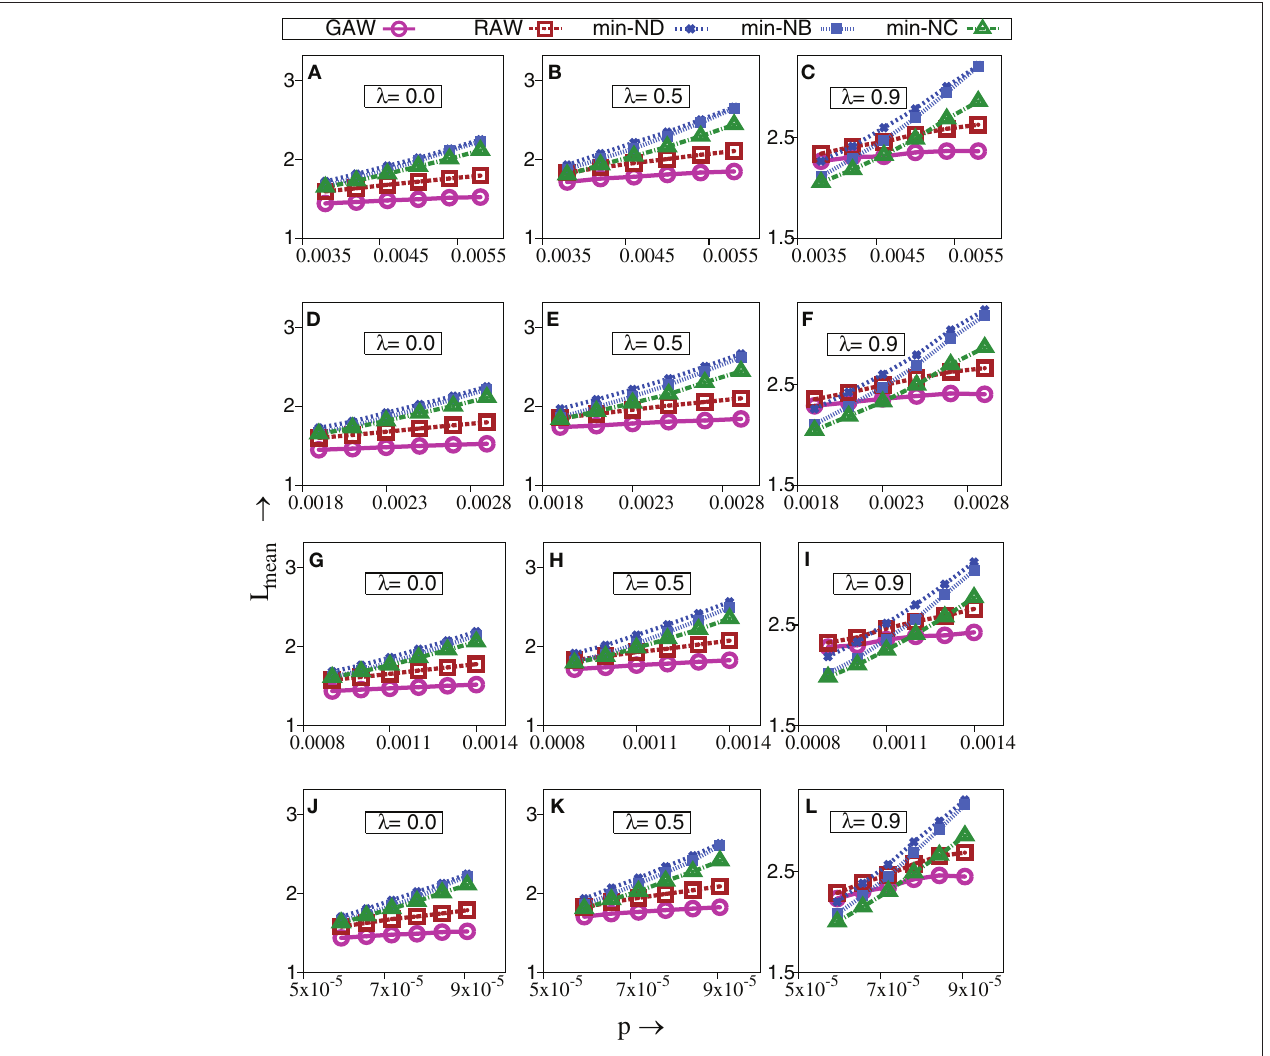
FIGURE 2 | Change in mean walk length of strictly adaptive walks (RAW, GAW) and topologically inspired walks (TIW) governed by minimum value of degree ( ND ), betweenness ( NB ) and closeness ( NC ) of nodes vs. probability of connections, p . The topology of the genotype space is based upon Erdös Rényi graphs. The fitness values are drawn from a bivariate Gaussian distribution having correlation parameter, λ and σ 2 = 0.001, α = 20. (A–I) Are for a set of N E = 10 3 networks, with 10 3 walks performed on each network of nodes N = 512,1024, and 2048, respectively, resulting in a total of 10 6 walks at a given value of p . (J–L) are for a set of N E = 500 networks, with 10 3 walks performed on each network of N = 32768 nodes, resulting in a total of 5 × 10 5 walks at a given value of p . Independent of N , TIW can perform better than strictly adaptive walks on sparser random graphs at higher λ . The standard error is smaller than the size of the data